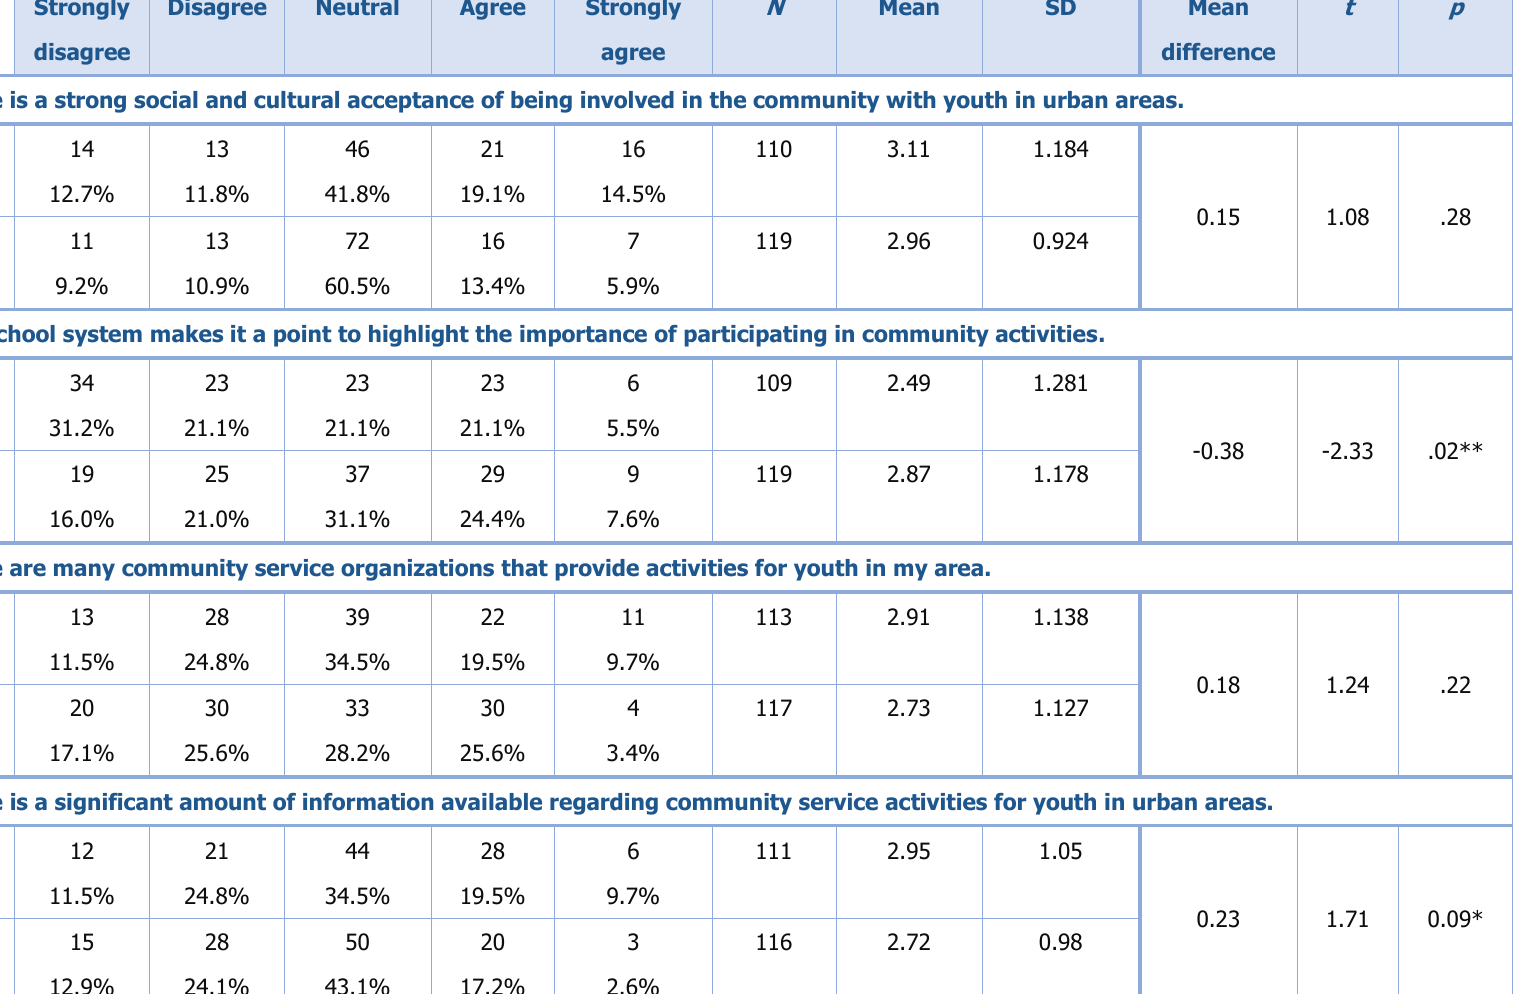
N Mean SD Mean agree